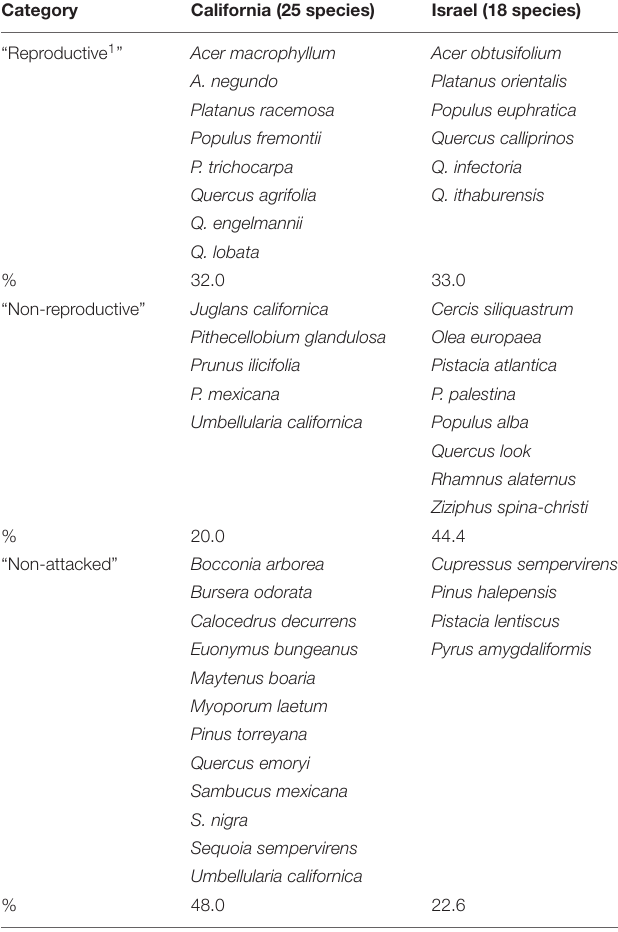
TABLE 3 | Examined indigenous tree species in California and Israel, and category as related to their susceptibility to the PSHB.